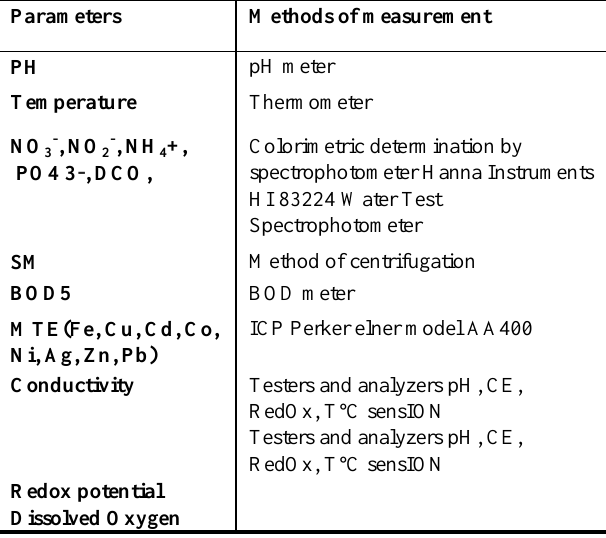
Table2. Methodology of Physico-chemical parameters, pollution indicators, and MTE.